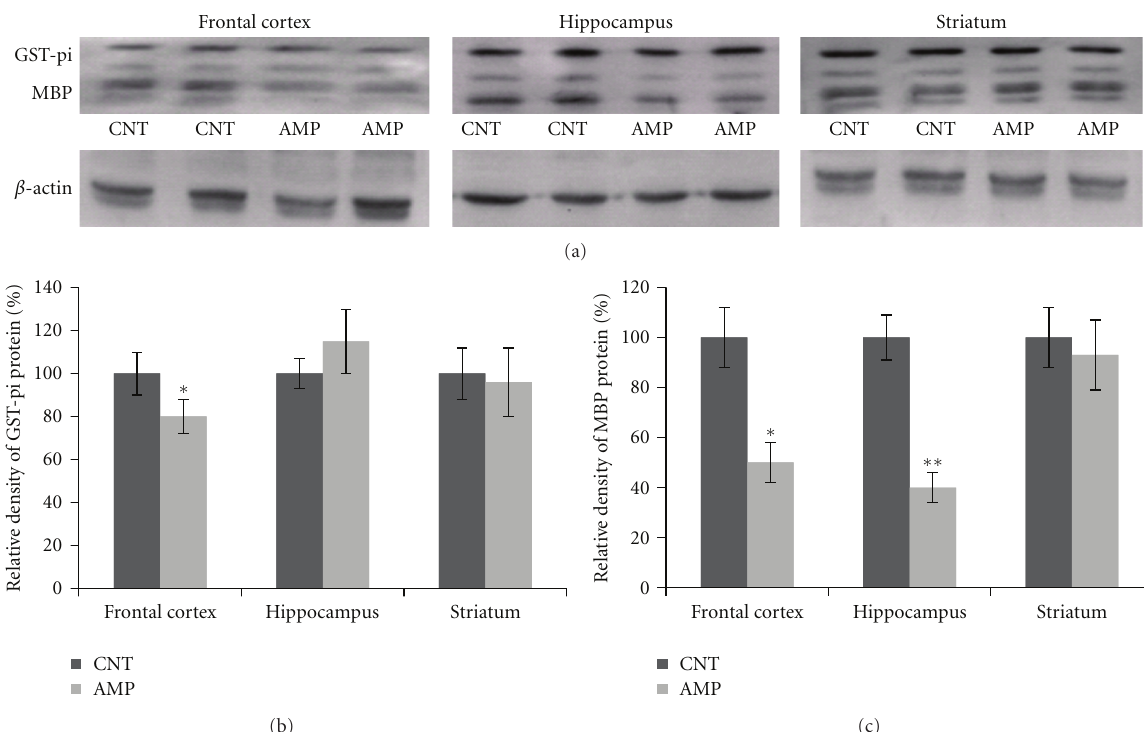
Figure 3: AMP reduced the amounts of GST-pi and MBP proteins in the frontal cortex and hippocampus. After treating with d-AMP or a same volume of saline for 21 days and subjected to behavioral tests, mice were sacrificed, their brains were dissected, and tissue samples from specific brain regions were processed for Westernblot analysis.The amountsof GST-pi and MBP proteins in the frontal cortex, hippocampus, and striatum were measured. (a) showsrepresentative Western blot images and (b) and (c) consistsof two bar charts illustrating the statistical analysis of the Western blot results. Data were expressed as means ± SEM. Comparisons were made between CNT and AMP groups. ∗ P < 0 . 05; ∗∗ P < 0 . 01. In the measurement of GST-pi protein, all 6 frontal cortex samples in the AMP group showed lower levels than the average of CNT group. In the measurement of MBP protein, all frontal cortex and hippocampus samples in the AMP group showed lower levels than the average of CNT